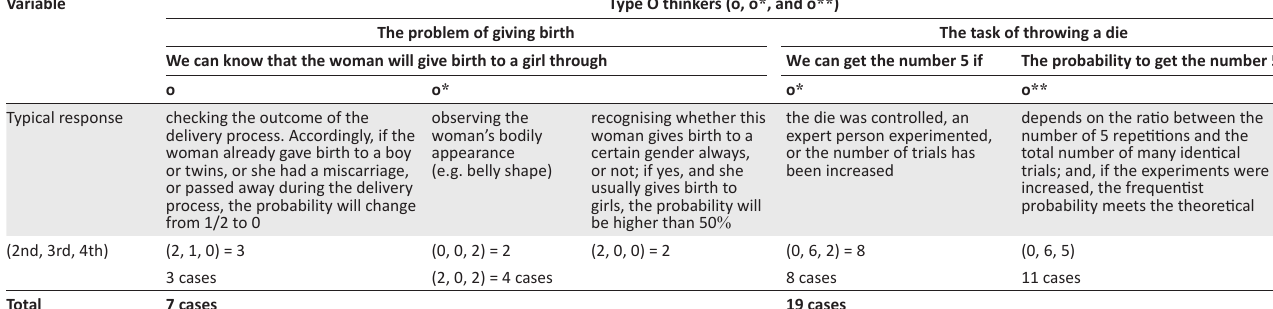
TABLE 5: Outcome-oriented thinkers (o, o * , and o ** reasoning). Variable Type O thinkers (o, o * , and o ** )